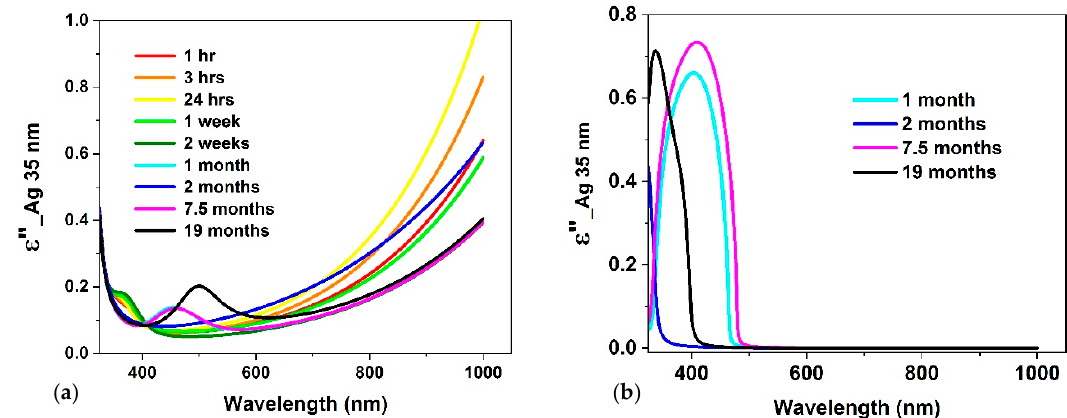
Figure 9. Dielectric permittivity imaginary part evolution for the 35 nm Ag thin films: ( a ) main layer; ( b ) roughness layer in the range of 330–1000 nm.